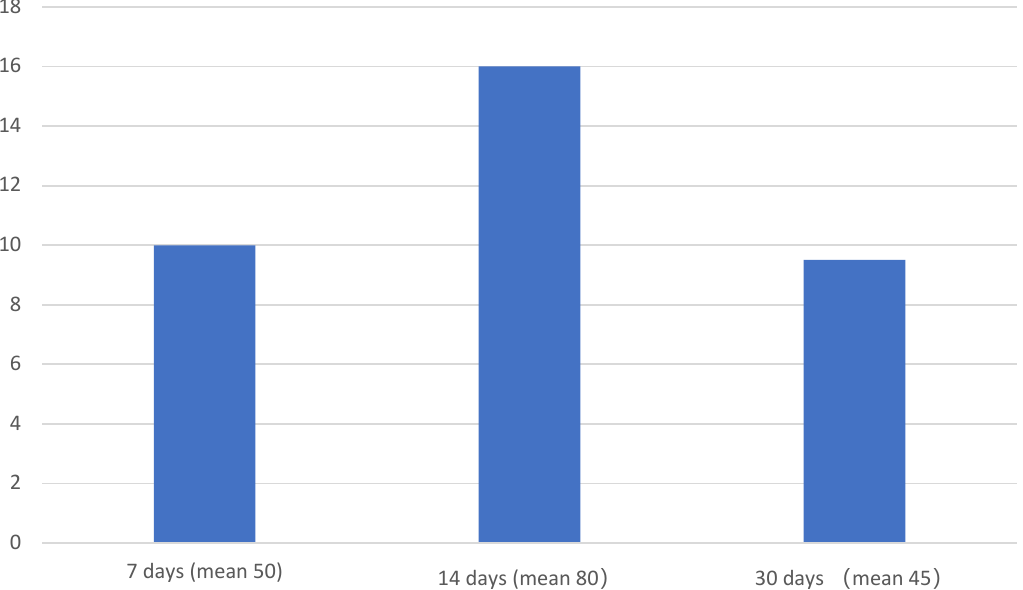
Figure 5. Graphic that shows the means of collagen I expression (blue columns) at 7, 14 and 30 days. The ANOVA test showed a significant statistical di ff erence among the means obtained at 7, 14 and 30 days of treatment ( p -value < 0.05).